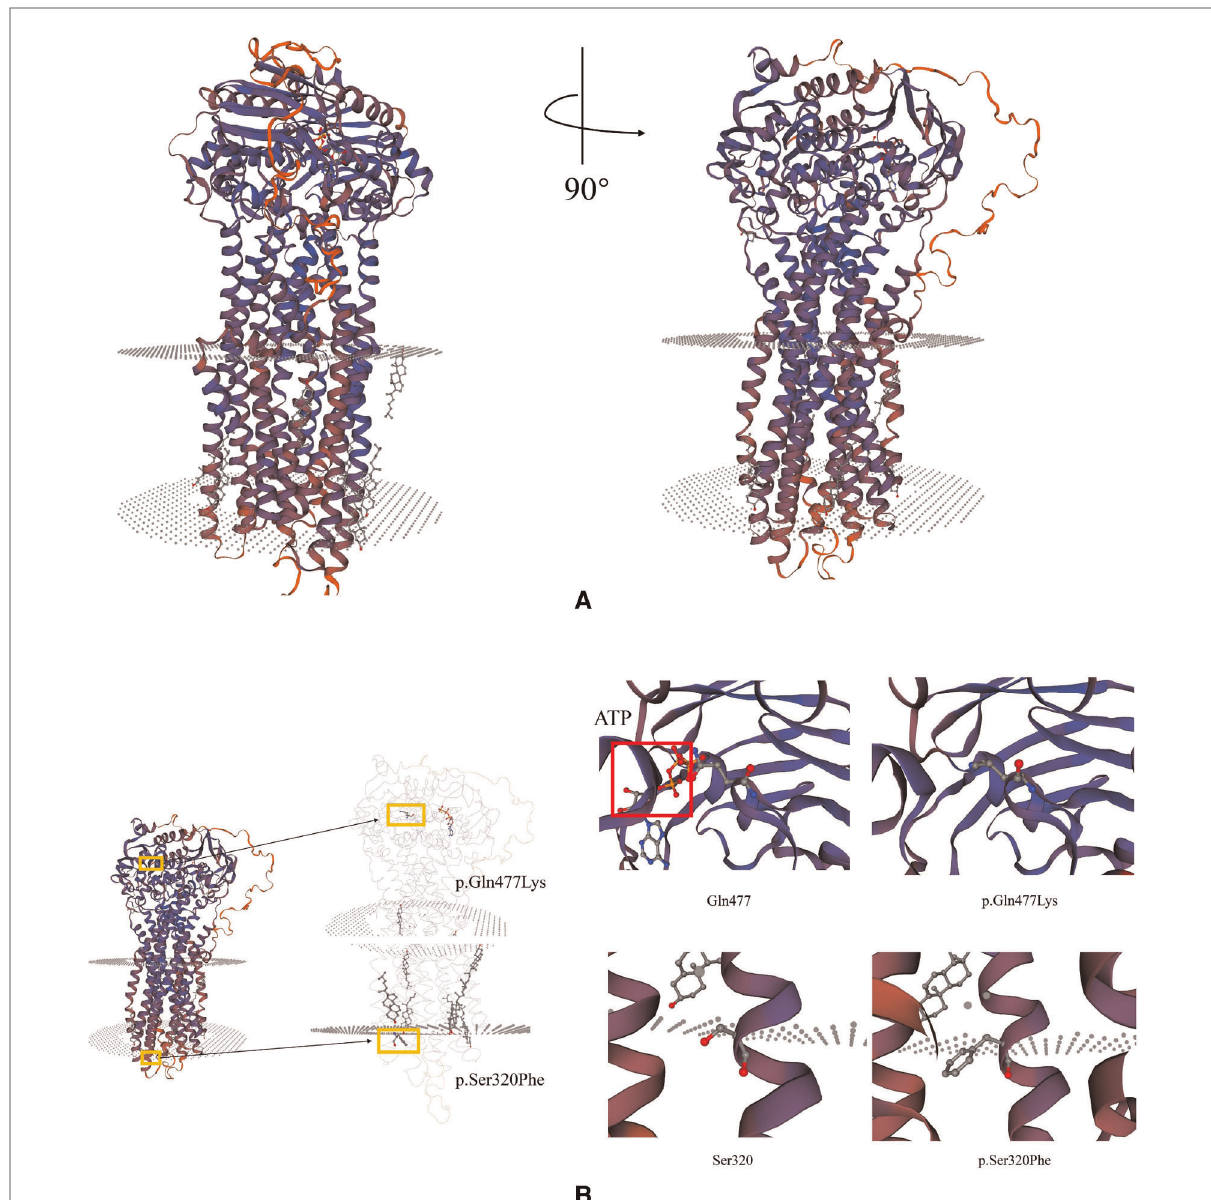
FIGURE 3 Schematic representation of missense variants p.S320F and p.Q477K on the ABCB4 protein. ( A ) Predicted tertiary structure of the ABCB4 novel pathogenic variant by SWISS MODEL. ( B ) Top: Structure modeling of wild type and p.Gln477Lys mutation of ABCB4 . Top left: The red square shows ATP-bond region. Top right: The mutant shows the loss of ATP-bonds, this might lose the ability to bind and hydrolyze ATP. Bottom: Wild type and p.Ser320Phe mutation of ABCB4